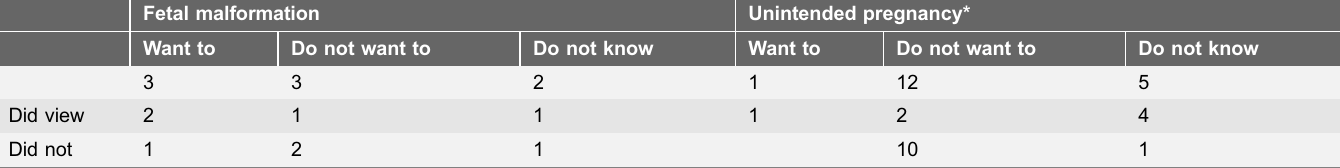
Table 5. Numbers of women who considered to view or not to view the fetus and who actually did so. Fetal malformation